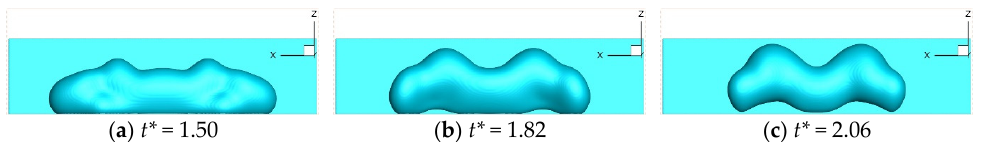
Figure 6. The side view of the coalesced droplet on the S2 surface. ( a – c ) Corresponds to the moments shown in Figure 5f–h.